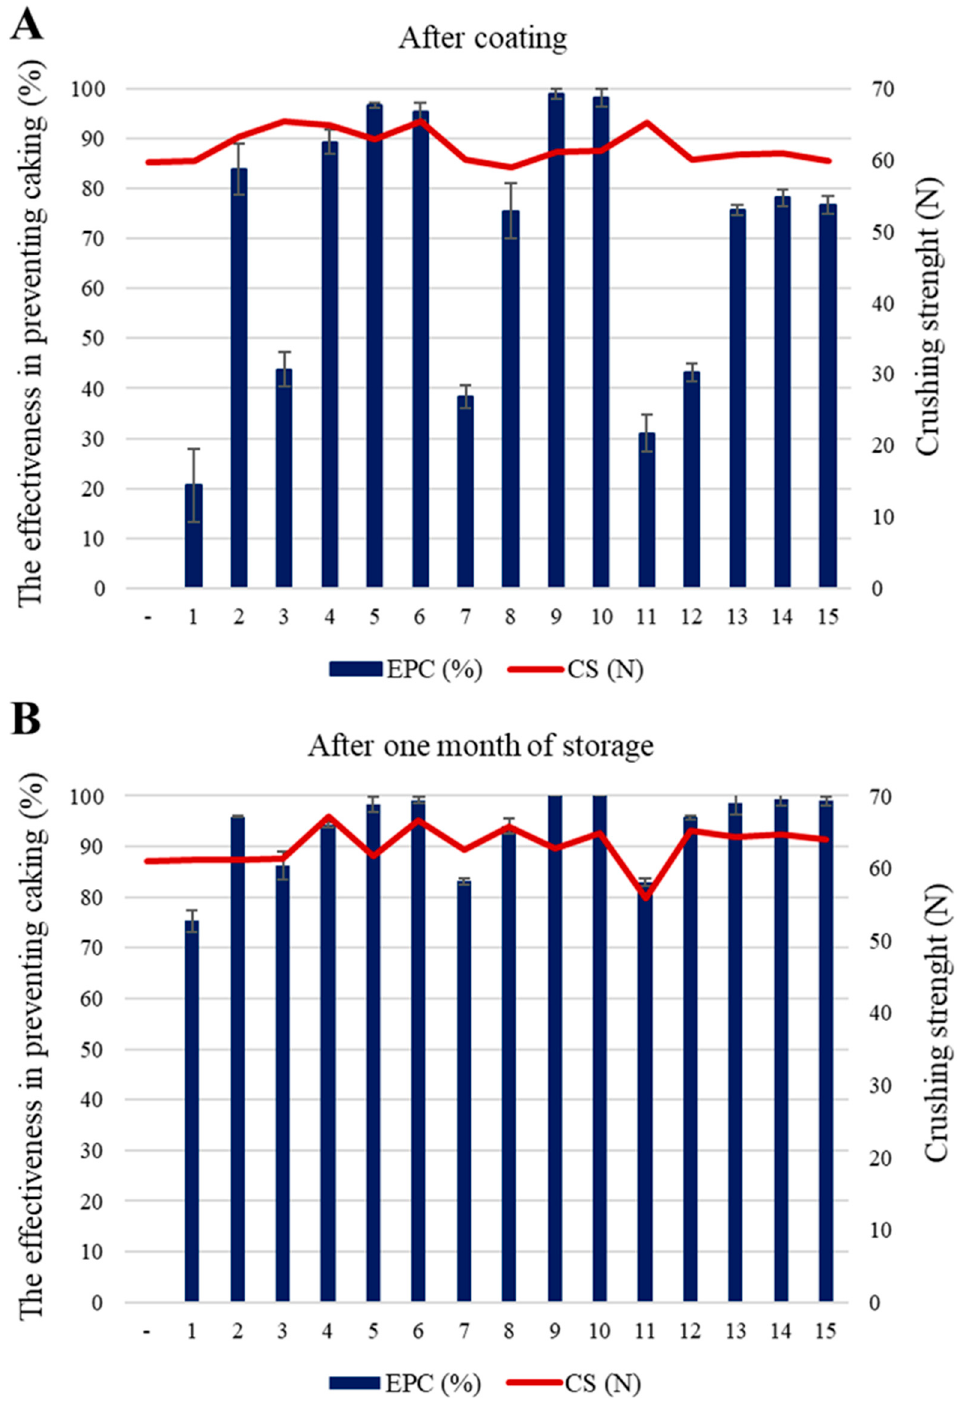
Figure 4. The effectiveness of anti-caking coatings and the crushing strength of granules: ( A ) after coating; and ( B ) after one month of storage.